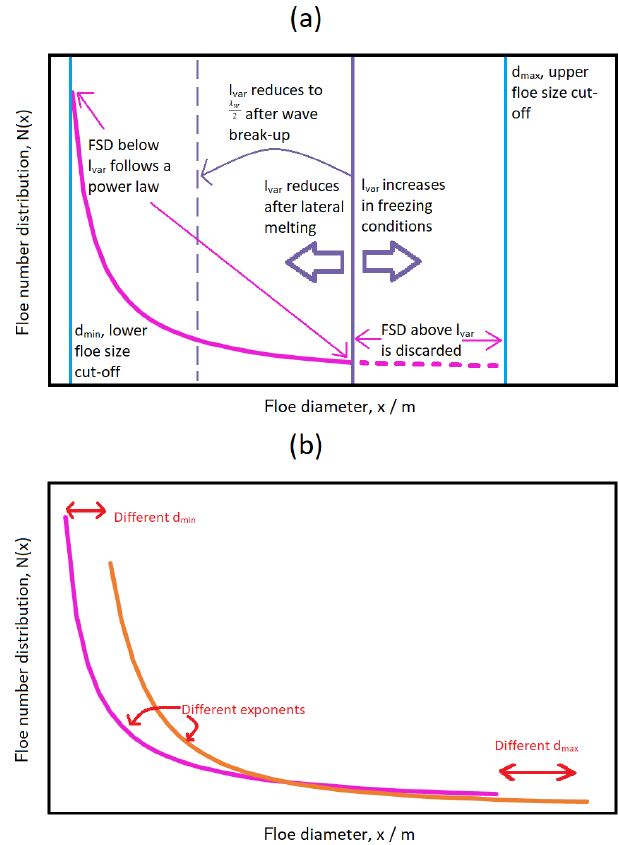
Figure 1. Panel (a) is a schematic of the imposed FSD model. This model is initiated by prescribing a power law with an exponent, α , and between the limits d min and d max . Within individual grid cells the variable FSD tracer, l var , varies between these two limits. l var evolves through lateral melting, wave break-up events, freezing, and advection. Not shown is how changes in l var will also impact the floe size number distribution factor, C . Panel (b) shows how d min , d max , and α can all be varied to produce floe size number distributions. All axes within both panels are logarithmic to base